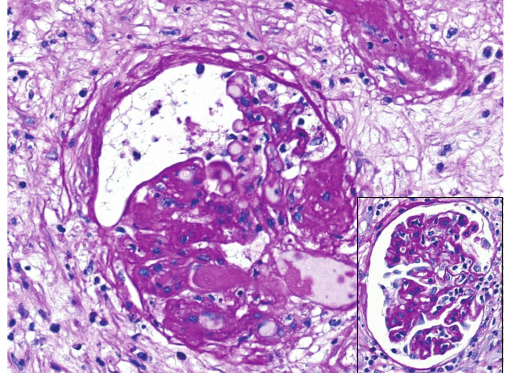
Figure 7: Immunohistochemical staining for C4d shows di ff use linear and strong circumferential staining in the peritubular capil- laries, consistent with acute antibody-mediated rejection (C4d IHC ×